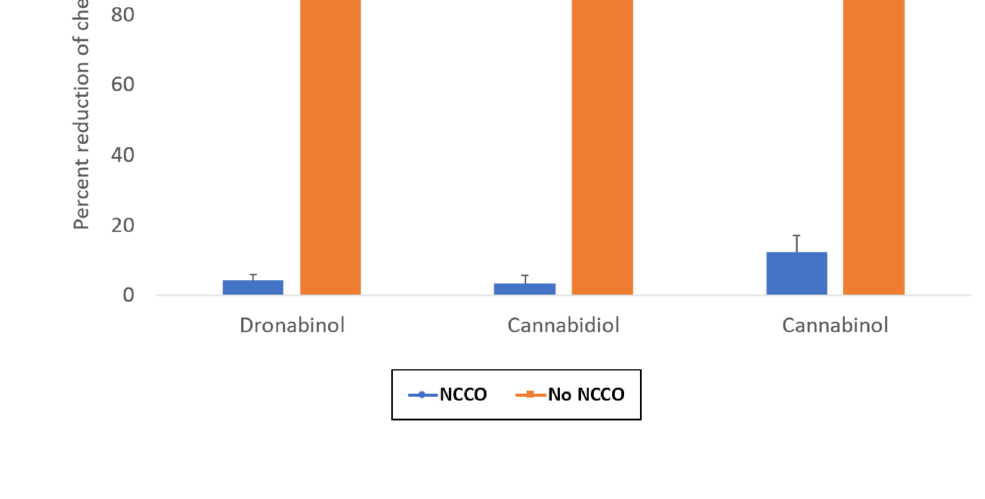
Fig. 1 Summary of percentage reduction for Dronabinol, Can- nabidiol and Cannabinol after 30 min of NCCO treatment. Error bar represents 1 SEM. * p < 0.05